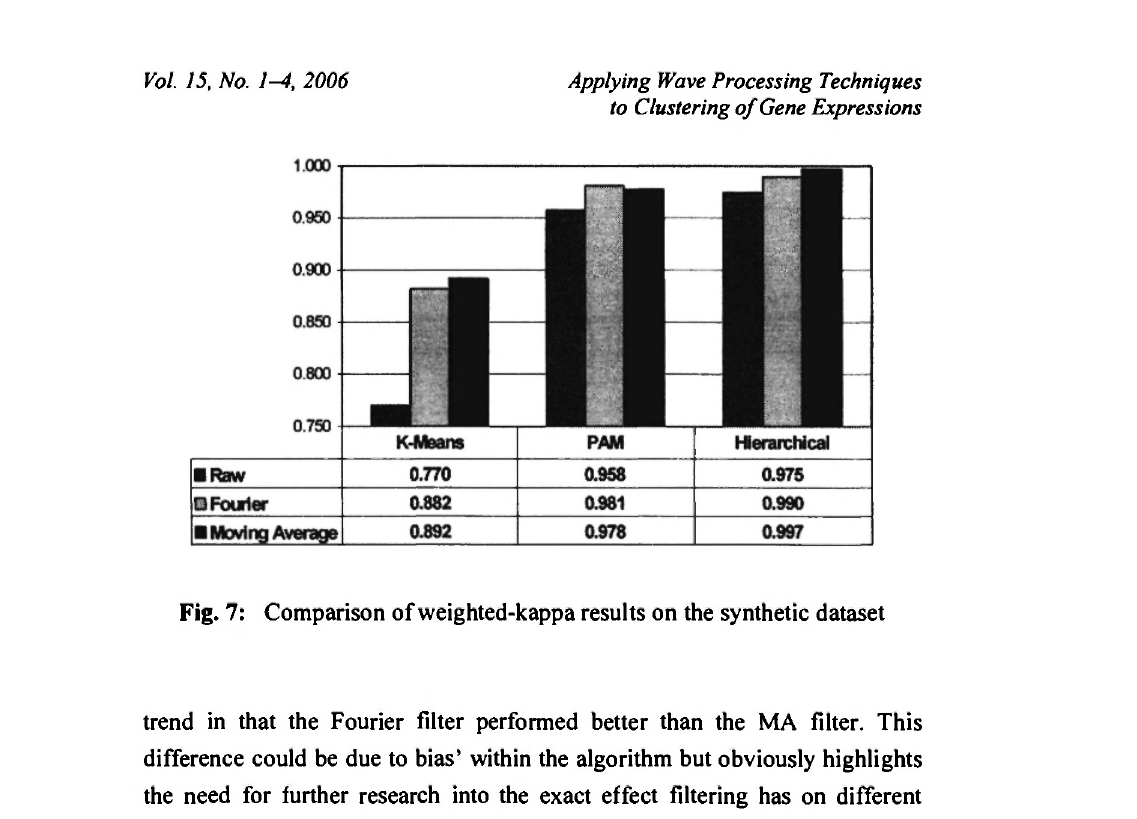
trend in that the Fourier filter performed better than the MA filter. This difference could be due to bias' within the algorithm but obviously highlights the need for further research into the exact effect filtering has on different